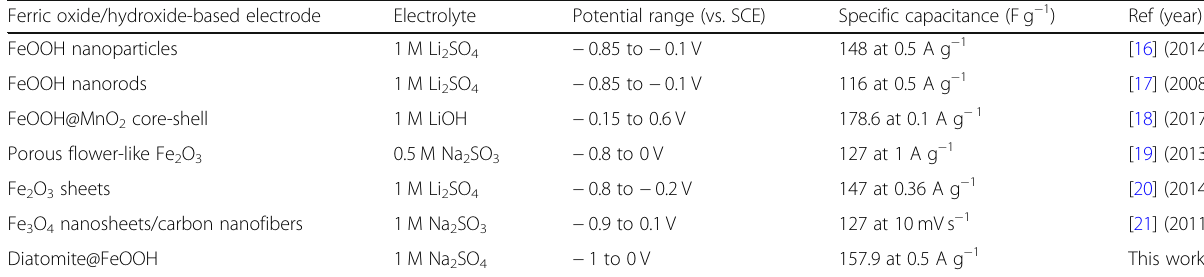
Table 1 Comparison of electrochemical performance for the ferric oxide/hydroxide based electrodes Ferric oxide/hydroxide-based electrode Electrolyte